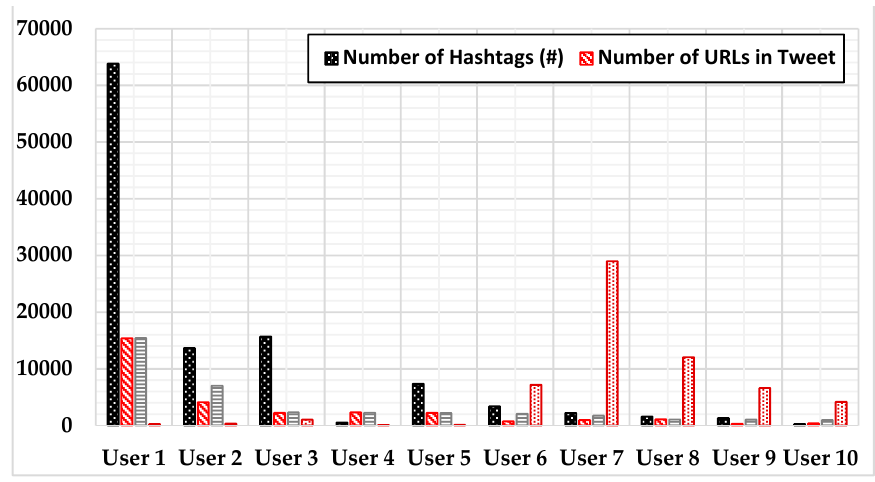
Figure 4. The top ten Twitter users with the highest number of twitter posts, as well as the number of